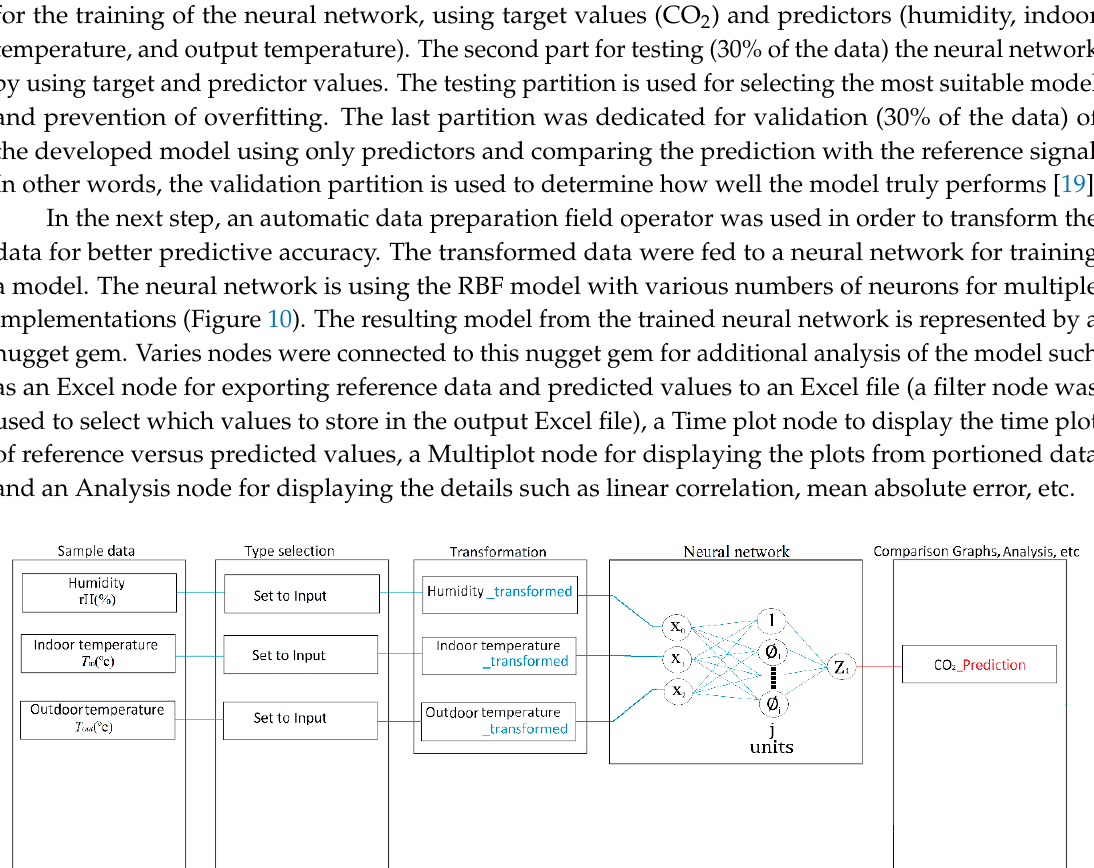
Table 1. The trained models—Training period: May 2018.